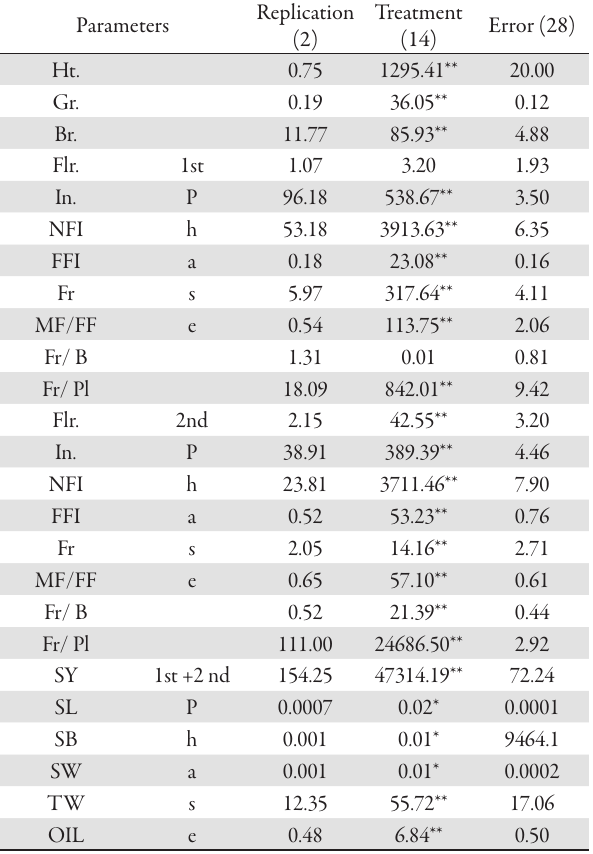
Tab. 5. Analysis of variance for growth, phenological and seed characters of Jatropha curcas as influenced by N, P and K